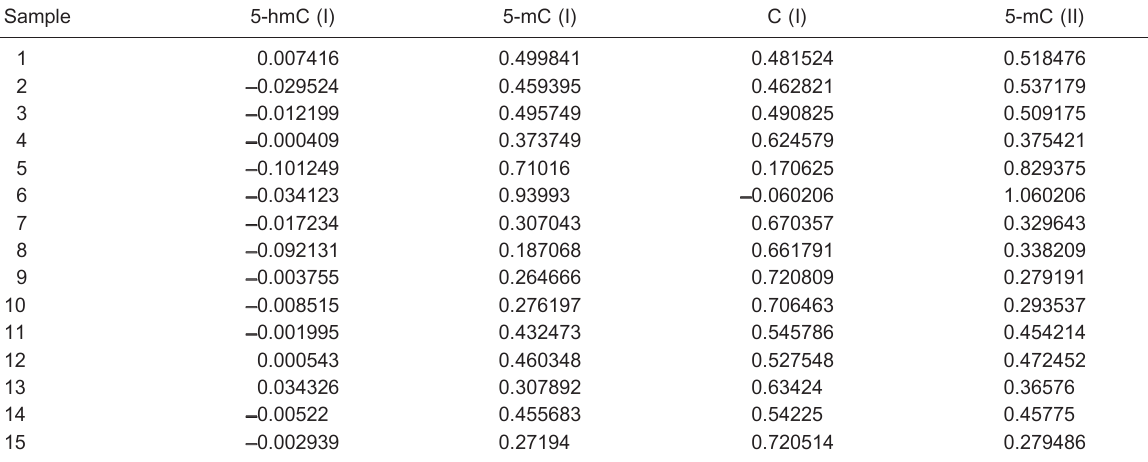
Table 2. Quantification of hydroxymethylation and methylation in the human placenta. Sample